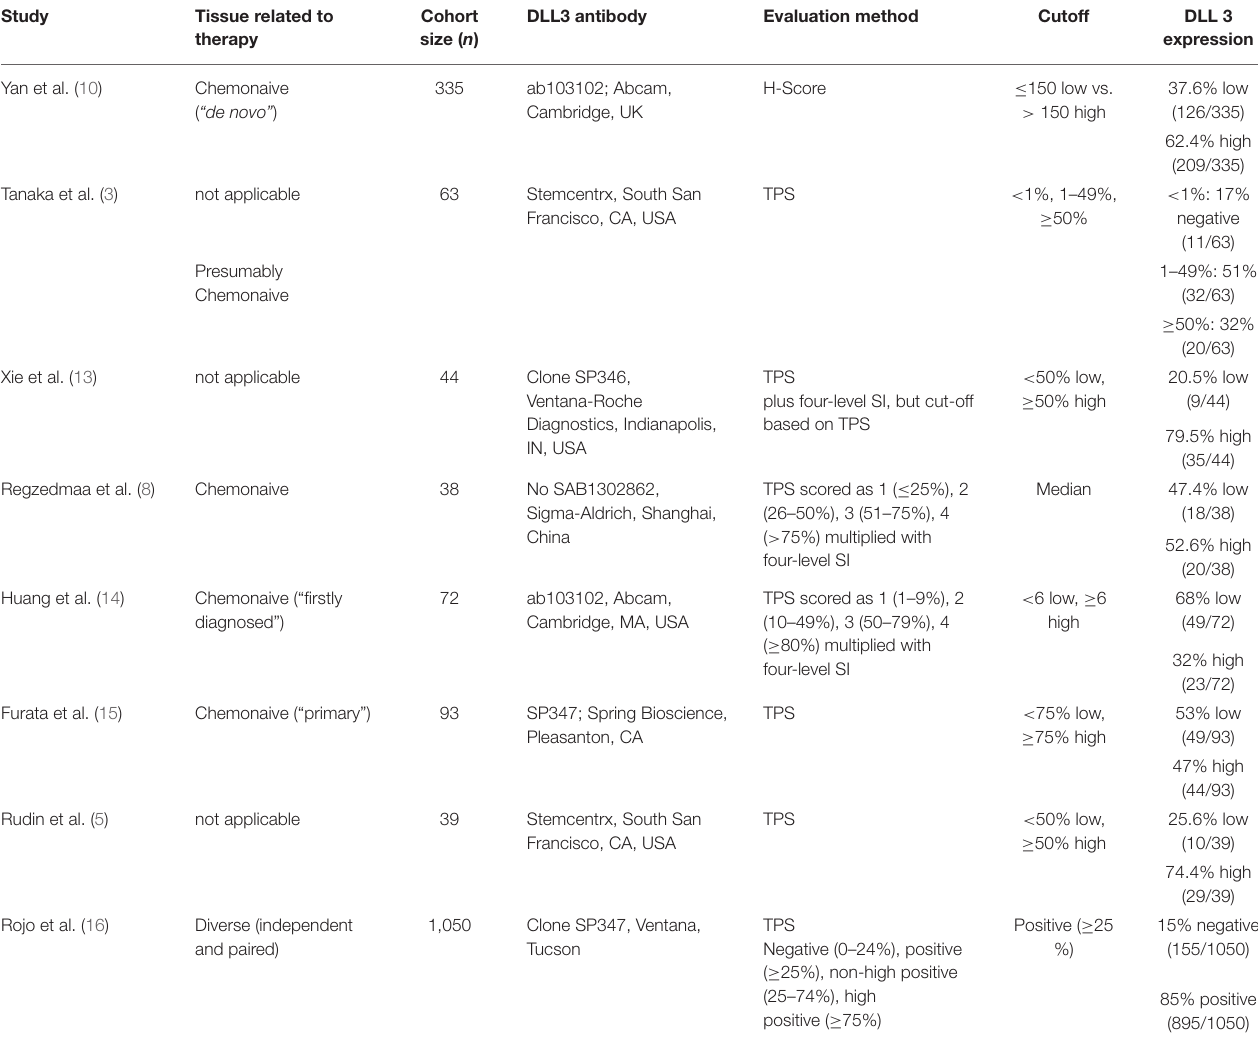
TABLE 3 | Overview of recent studies on DLL3 expression in